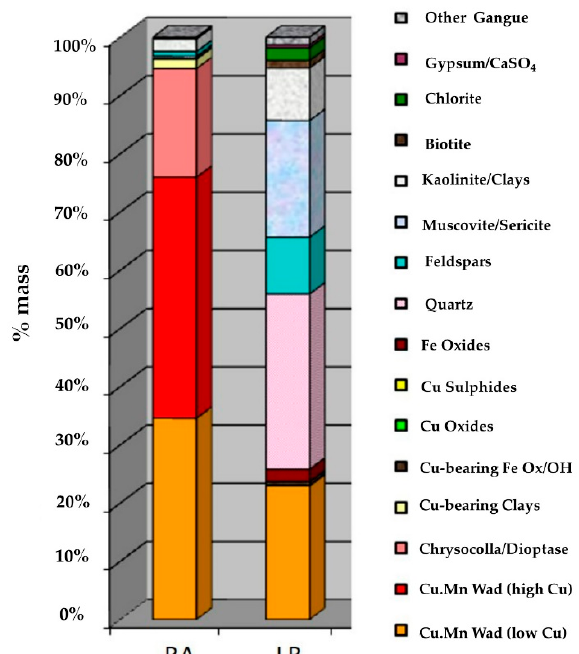
Figure 3. Mineralogical analysis by Qemscan of samples RA and LB.